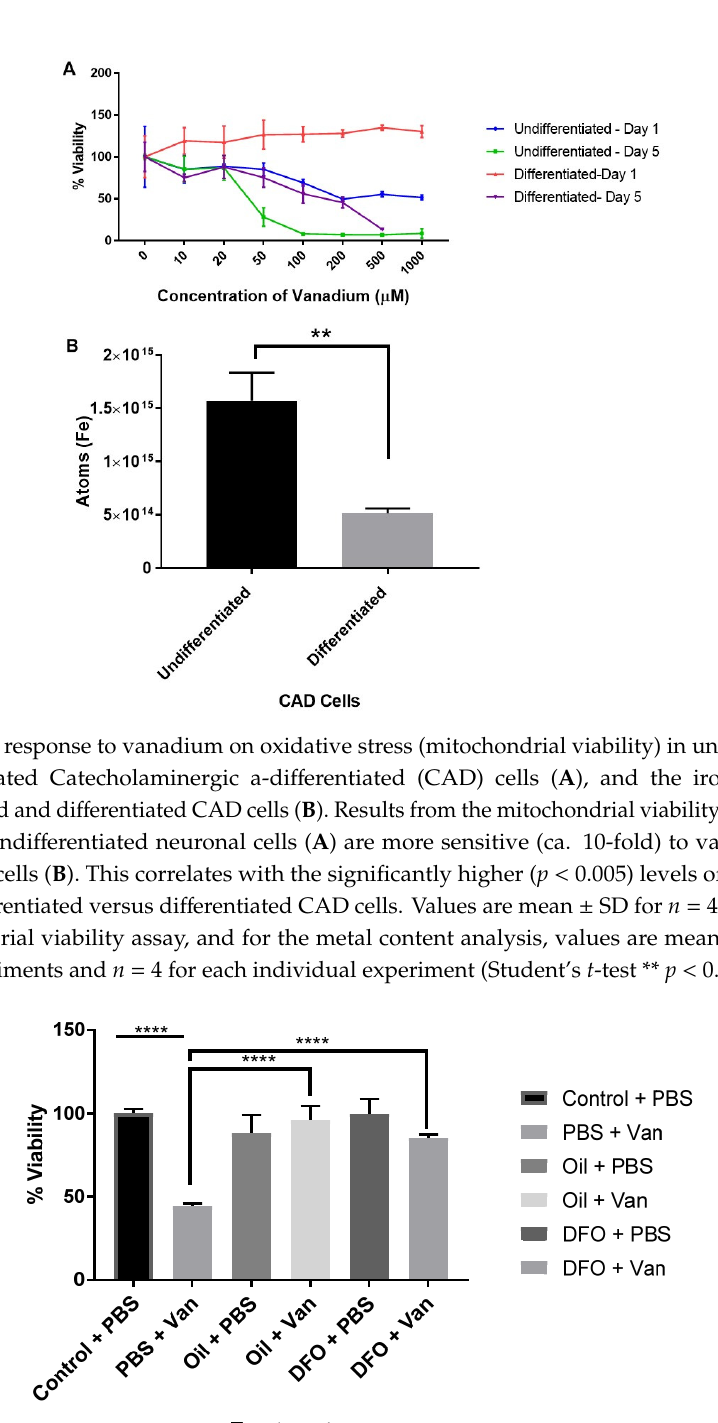
Figure 2. E ff ects of iron chelation on the chronic exposure to vanadium in di ff erentiated CAD cells. The e ff ects of the synthetic (deferoxamine, DFO) and natural iron chelator ( A. citrodora essential oil) upon vanadium (200 µ M)-induced oxidative stress (mitochondrial viability) following chronic (six-day) exposure for di ff erentiating CAD cells. Both synthetic and natural chelators significantly reversed vanadium-induced toxicity, as compared with vanadium-only treated cells. The concentration of DFO used was 10 µ M, and A. citrodora was 0.01 mg / mL. Values are mean ± SD for n = 4 samples. **** p < 0.0001. A repeated measure one-way ANOVA (with Tukey’s multiple comparisons test) was